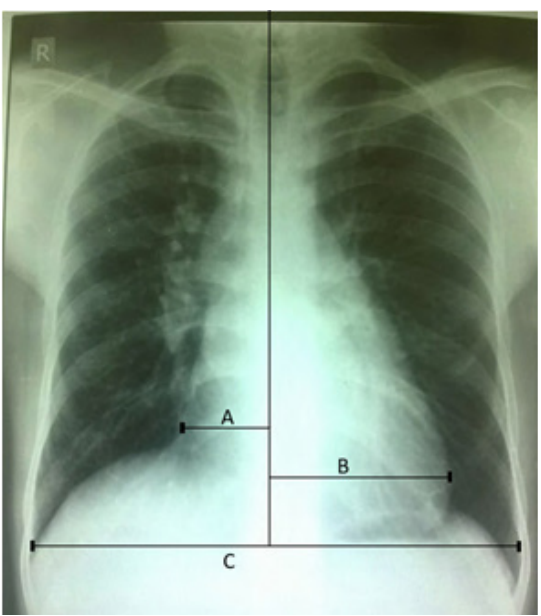
Management The center at which the patient presented was not